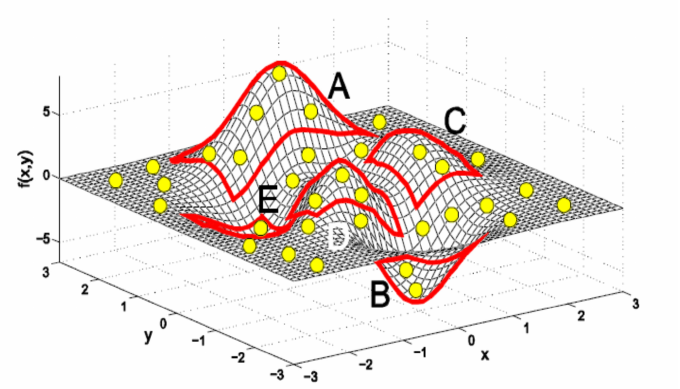
Figure 4. Data reduction effect: Training process